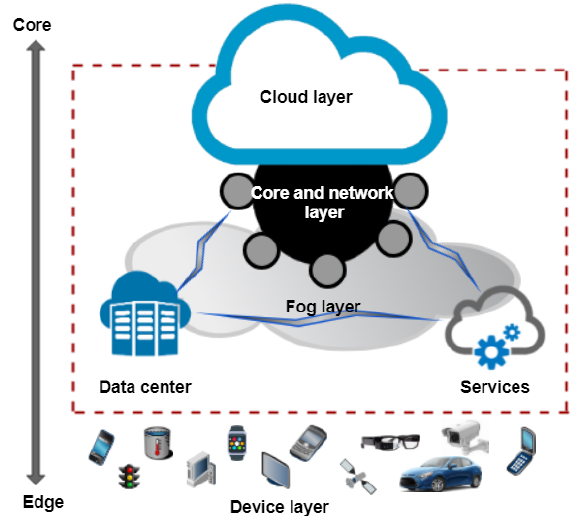
Figure 3. Functionality-based fog